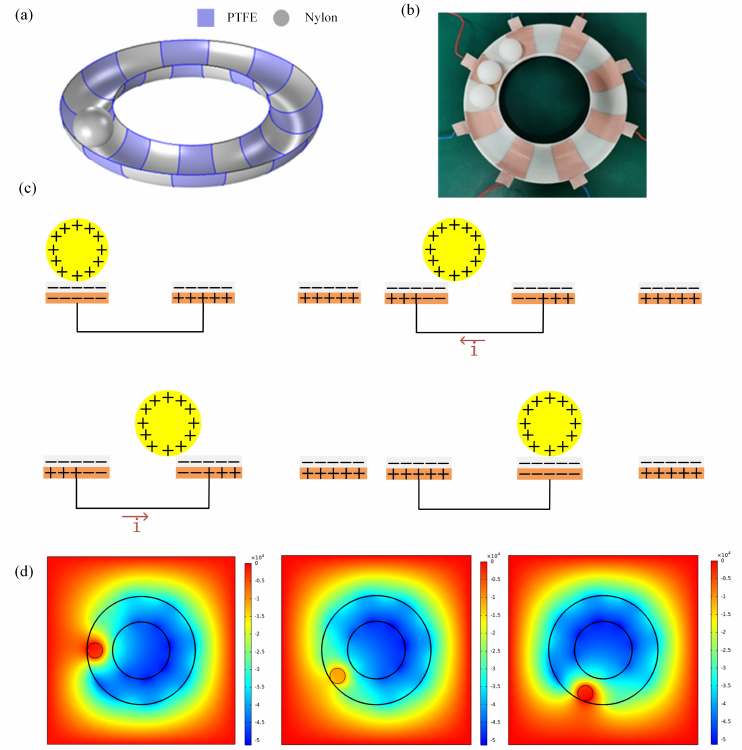
Figure 1. Structure, working principle, and potential distribution of the device based on an annular- shaped triboelectric nanogenerator (A-TENG). ( a ) Schematic diagram of the structure of the A-TENG. ( b ) Photo of the physical section of the fabricated A-TENG. ( c ) The working principle of the A-TENG in the working mode. ( d ) The potential distribution at different rolling